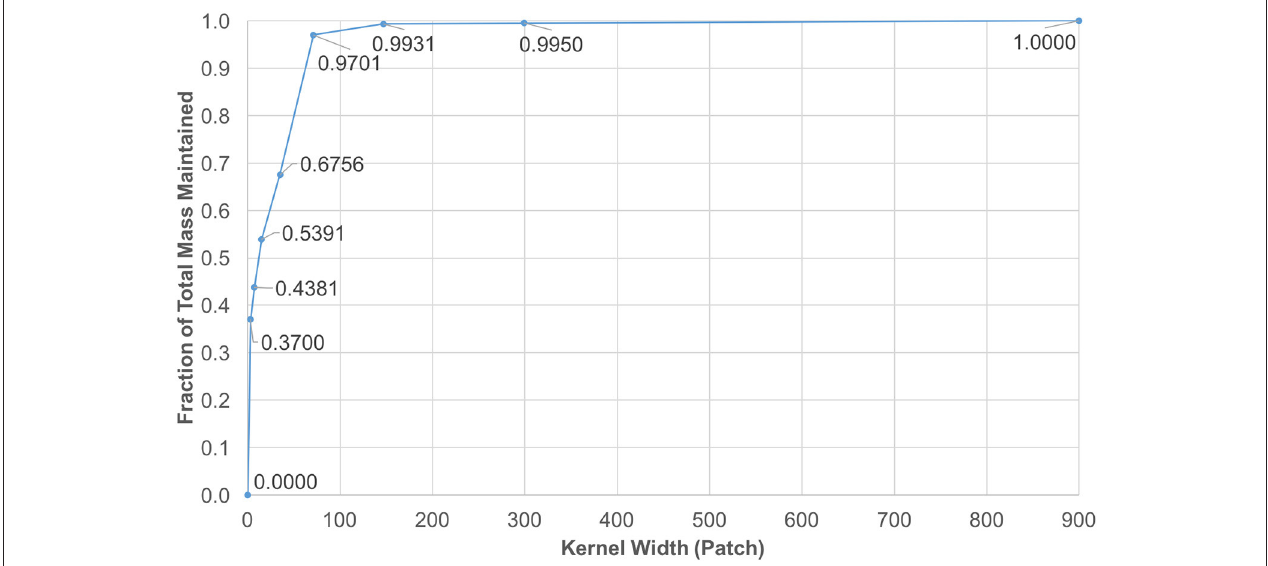
FIGURE 3 | Diffusion kernel reduction mass vs. kernel width. This plot shows mass coverage with respect to extracted window width. The size of each kernel is width 3 patches. It is observed that by cutting down the size from 1,441 3 down to 147 3 , only a fraction of 0.0069 of the mass is lost in each